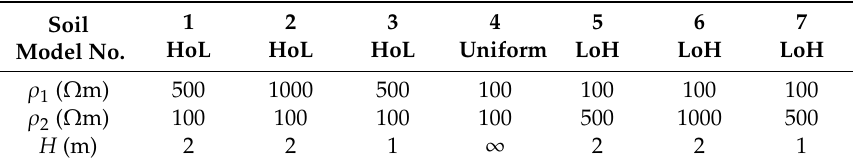
Table 1. Sensitivity analysis soil